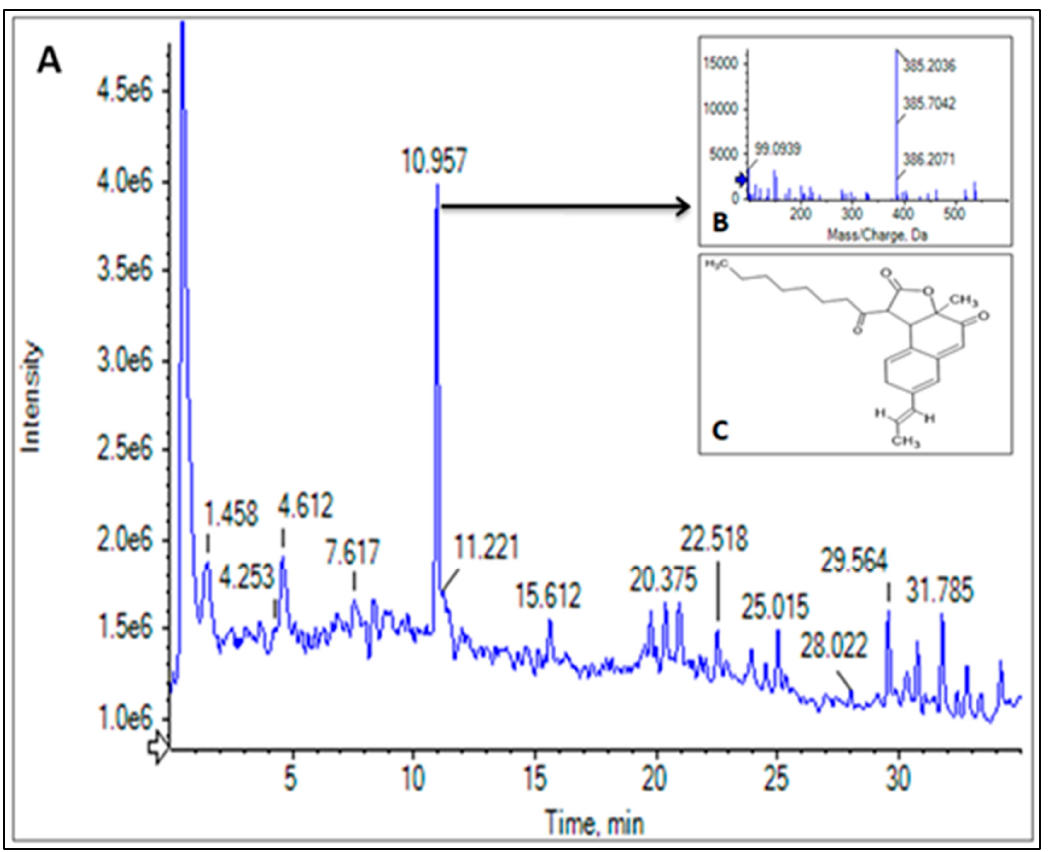
Figure 6. ( A ) Liquid chromatogram of methanolic extract of CPEF02, the arrow on the y-axis indicating base (starting point) for the intensity, ( B ) mass spectra of Monasfluore B at retention time 10.965, ( C ) molecular structure of Monasfluore B. Table 3. Pigmented compounds in the methanol-extracted CPEF02 colourant determined using LC-HRMS analysis. Analyte No.